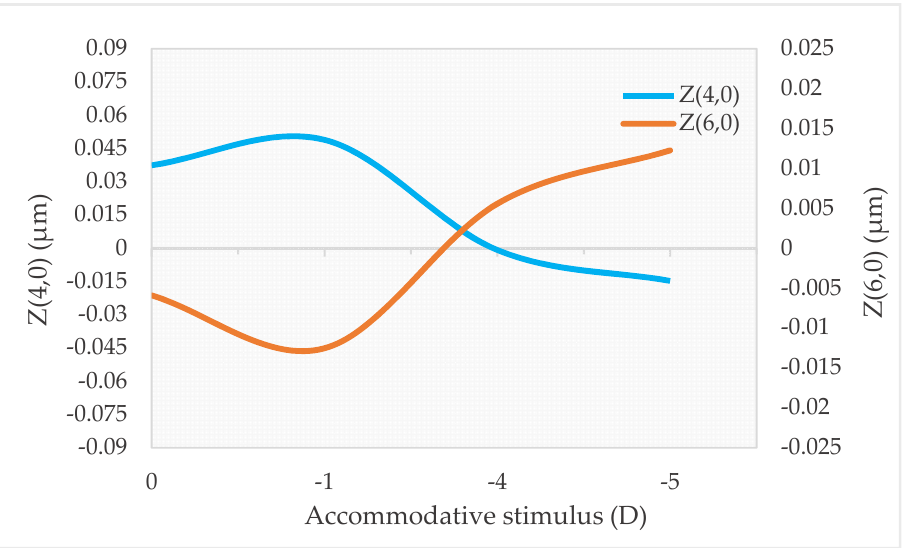
Figure 2. Change of Z(4,0) and Z(6,0) with accommodation for different accommodative demands.